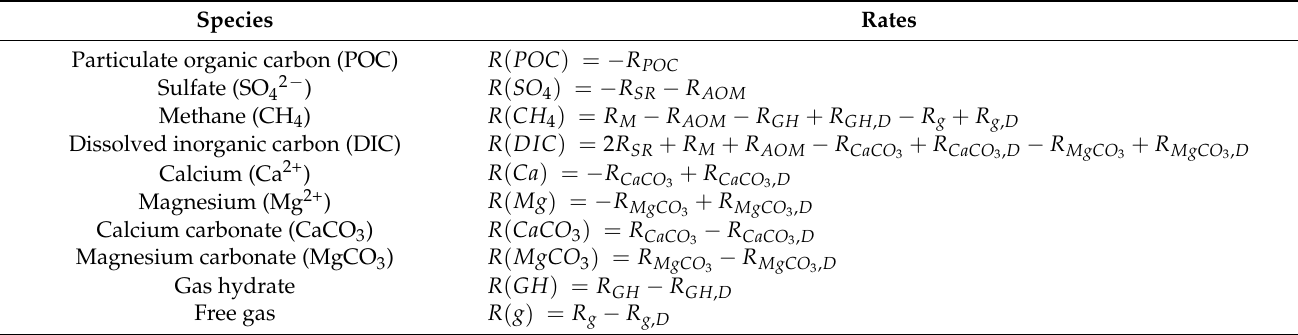
Table A3. Rate expression used in the differential equations.